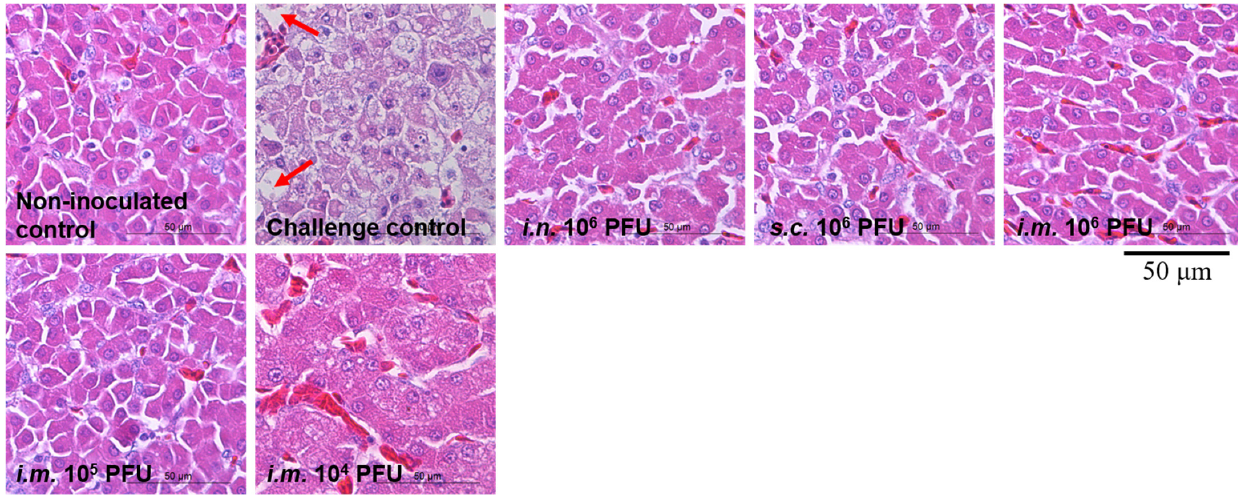
Figure 5. Histological examination of liver from chickens challenged with FAdV-4. Large necrotic focal areas and steatotic vacuoles were present in chicken liver cells from the challenge controls, whereas each immunization group was indistinguishable from the non-inoculated controls. Solid arrows indicate steatotic vacuoles. Scale bar, 50 μ m. Routes for immunization were: i.n. = intranasal, s.c. = subcutaneous, and i.m. = intramuscular.